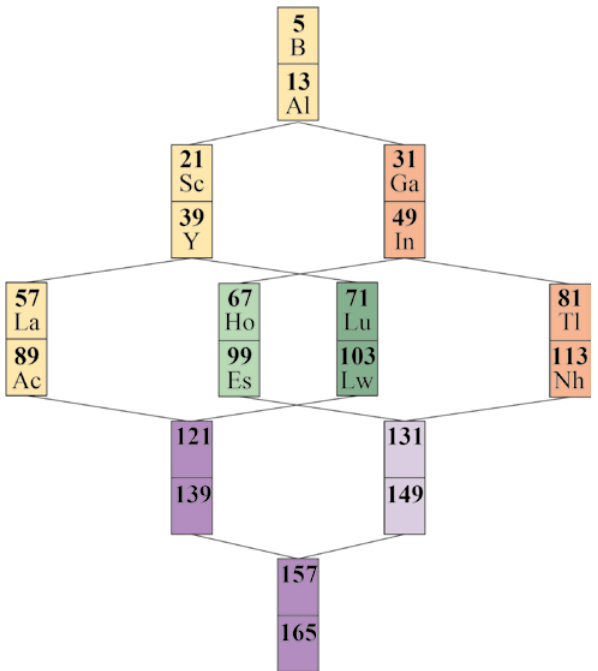
Figure 4. The periodicity tree